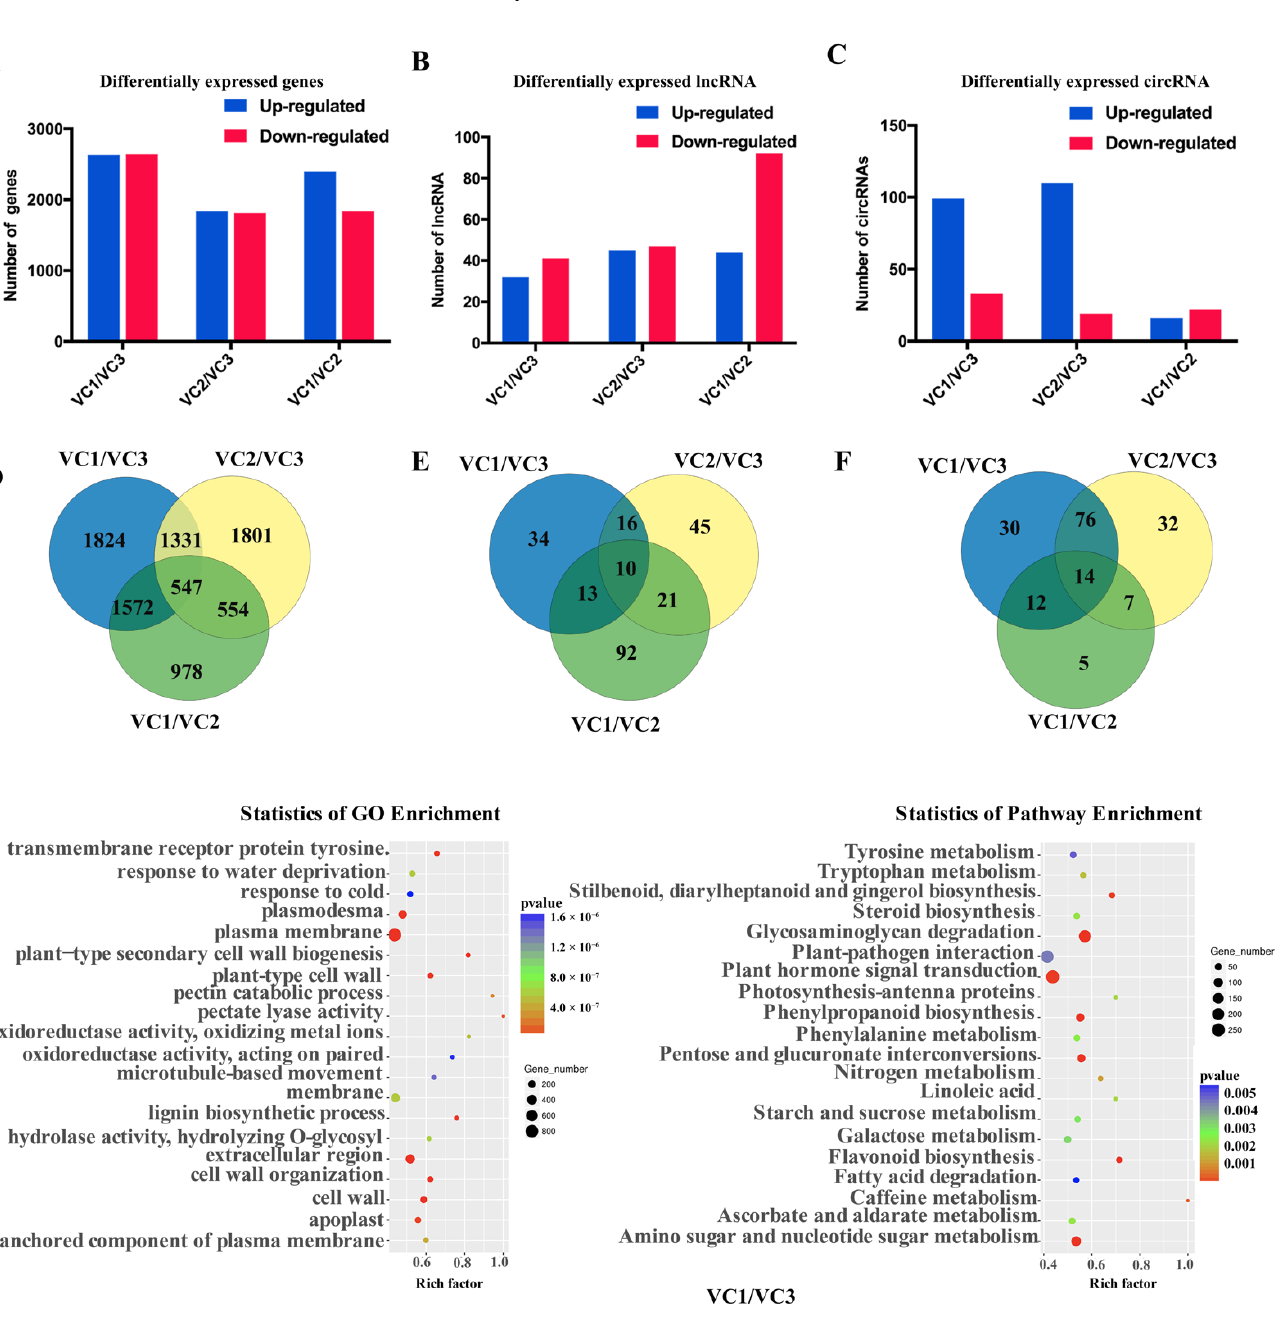
Figure 4. The analysis of differentially expressed genes, lncRNAs, and circRNAs. ( A ) numbers of differentially expressed genes. ( B , C ) numbers of differentially expressed lncRNAs and circRNAs. ( D – F ) differentially expressed genes, lncRNAs and circRNAs by Venn diagram. ( G ) GO and KEGG pathway enrichment of differentially expressed genes.